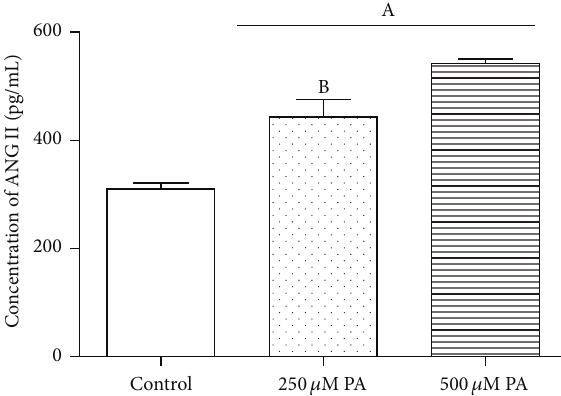
Figure 2: Concentrations of ANG II secreted by 3T3-L1 adipocytes after being treated by different concentrations of PA. Data are presented as mean ± SD. (A) 𝑃 < 0.05 versus control, (B) 𝑃 < 0.05 versus 500 𝜇 M PA ( 𝑥 ± 𝑠 , 𝑛 = 6 ).